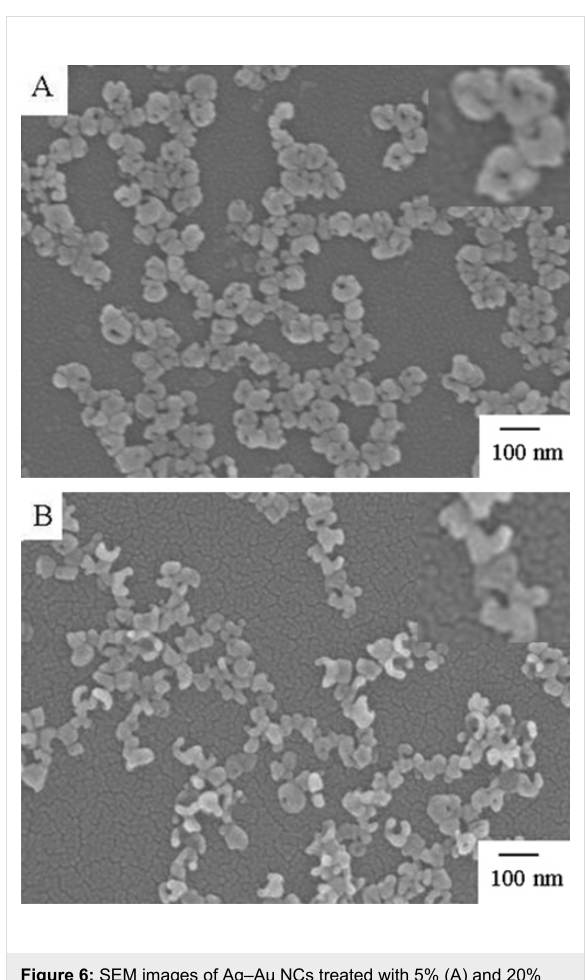
Figure 6: SEM images of Ag–Au NCs treated with 5% (A) and 20% HNO 3 (B) for 10 h at room temperature. Inset: the SEM images with higher